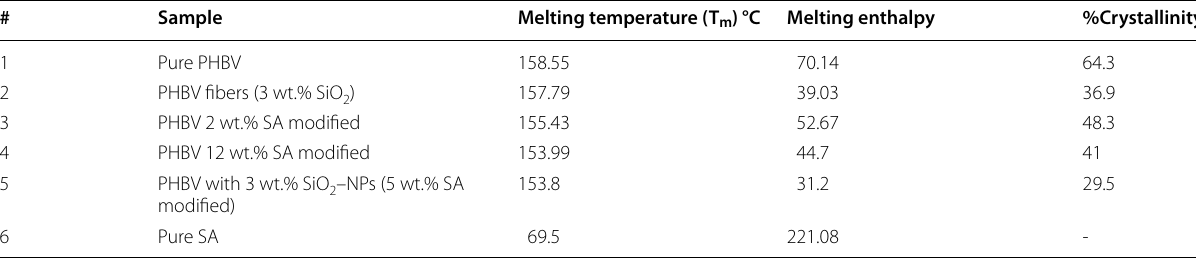
Table 2 Thermal analysis results obtained from DSC measurements of various